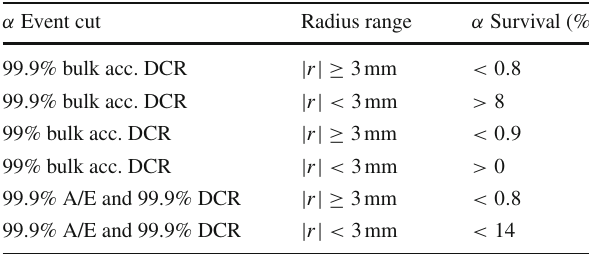
on the 90% confidence intervals. The average of the upper or lower limits is given, depending on the scanning position range in question. All included positions are weighted equally in the